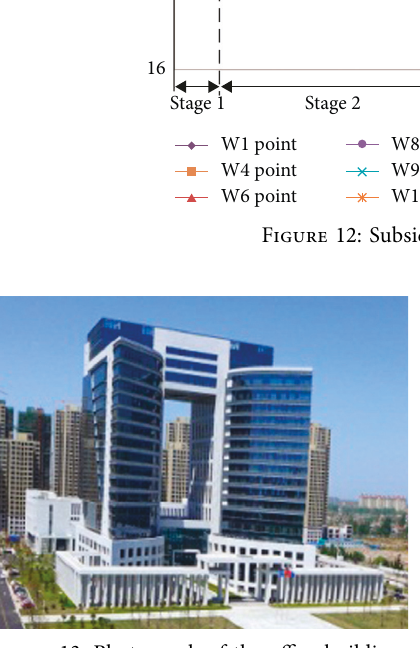
Figure 13: Photograph of the office